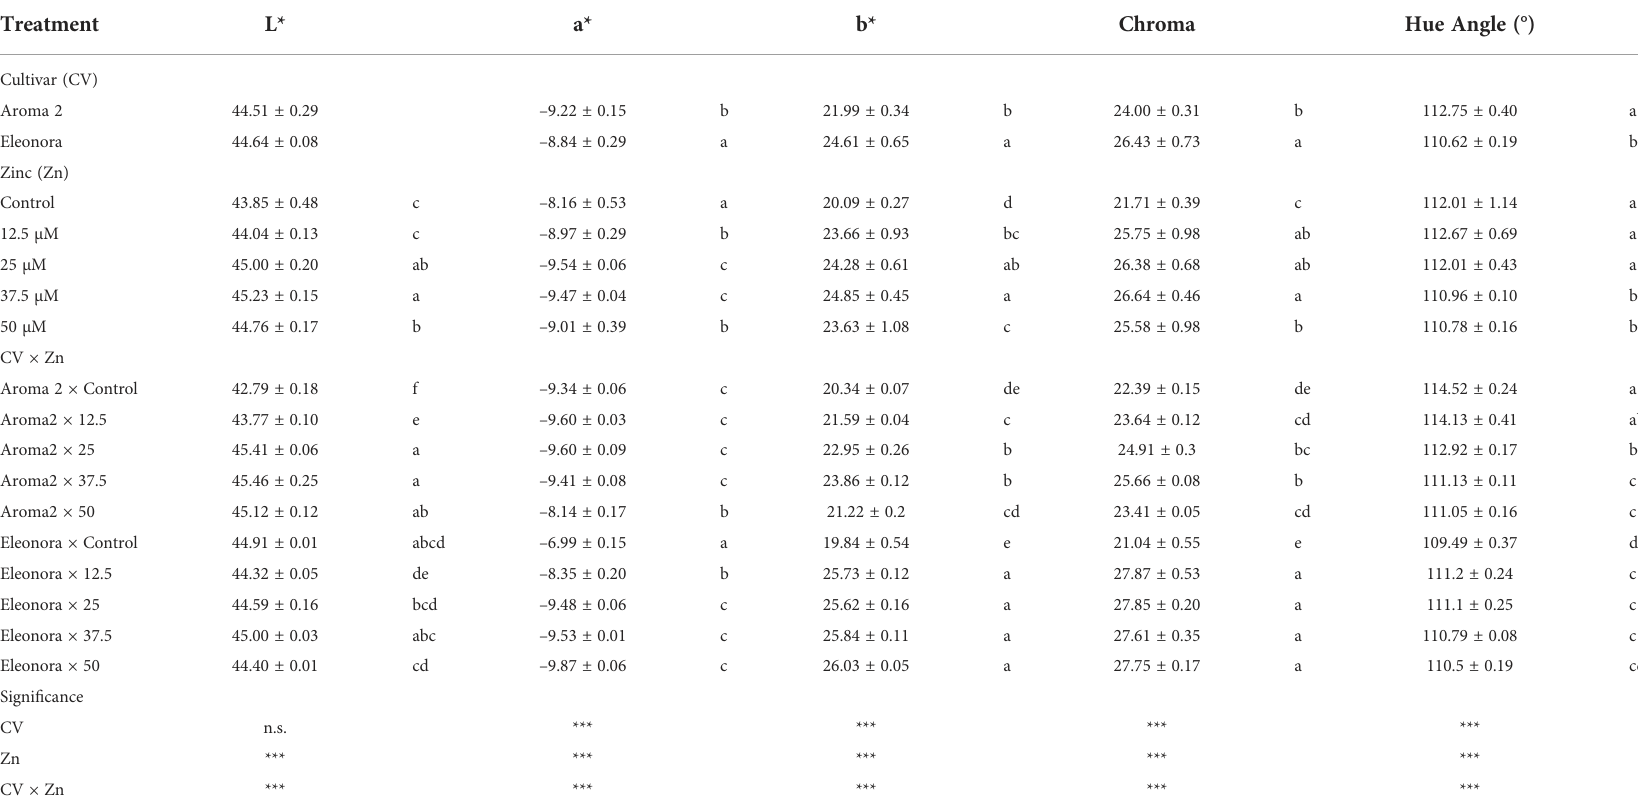
TABLE 2 Analysis of variance and mean comparisons for leaf colorimetric components L*, a*, b*, Chroma, and Hue angle of Aroma 2 and Eleonora basil cultivars grown hydroponically under different Zn treatments: 0 = Control; 12.5; 25; 37.5; 50 µmol of Zn].